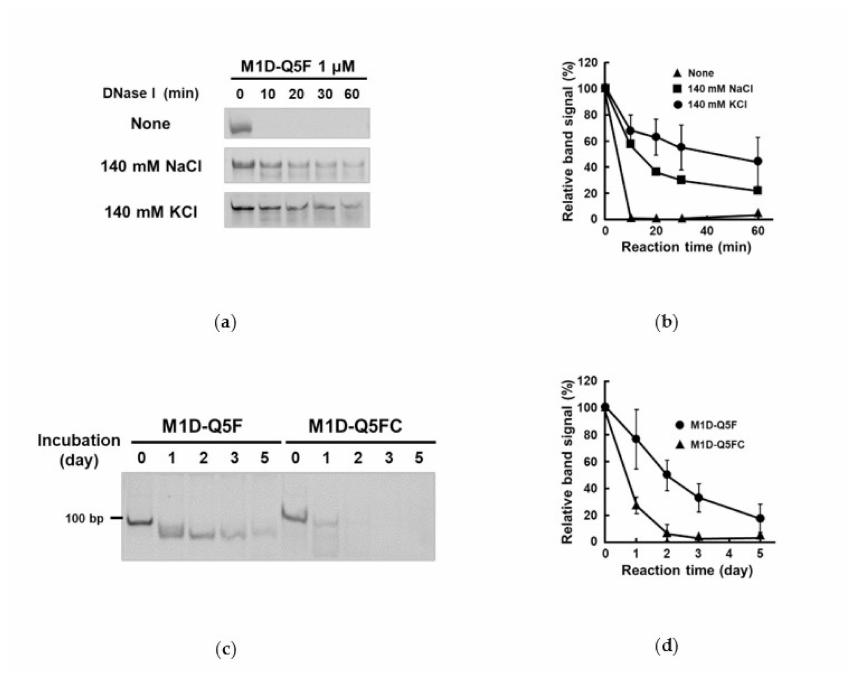
Figure 5. Stability of M1D-Q5F aptamer. ( a ) Ion dependency of DNase I resistance of M1D-Q5F in the solution with Na + or K + . ( b ) Quantitation of the data in (a). Data show relative band signal to 0 min and represent mean ± S.D. (n = 3) (triangle, w / o ion; square, Na + ; circle, K + ). ( c ) Stability of M1D-Q5F aptamer and M1D-Q5FC oligo in DMEM, 10% fatal bovine serum at 37 ◦ C for indicated days. ( d ) Quantitation of the data in (c). Data show relative band signal to 0 day and represent mean ± S.D.